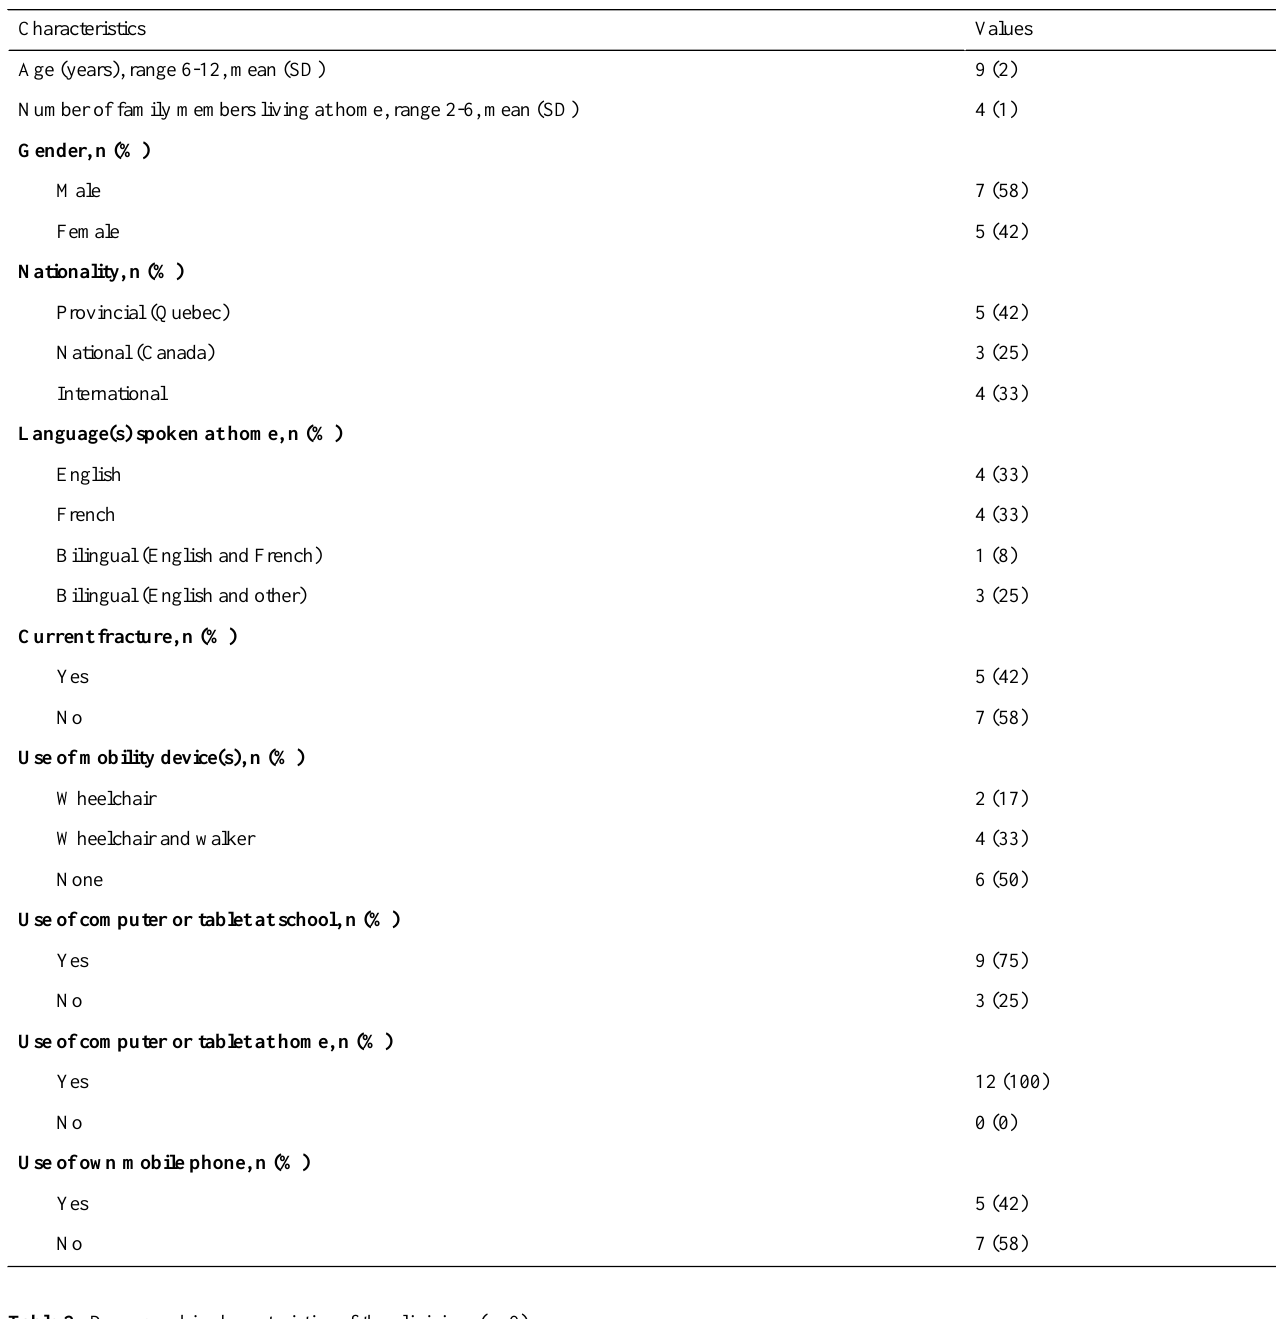
Table 1. Demographic characteristics of the children (n=12).